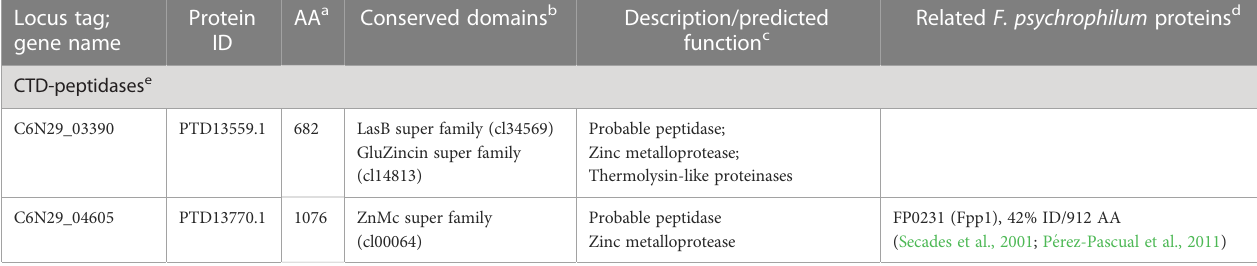
TABLE 2 Predicted domains and activities of F. columnare MS-FC-4 peptidases examined in this